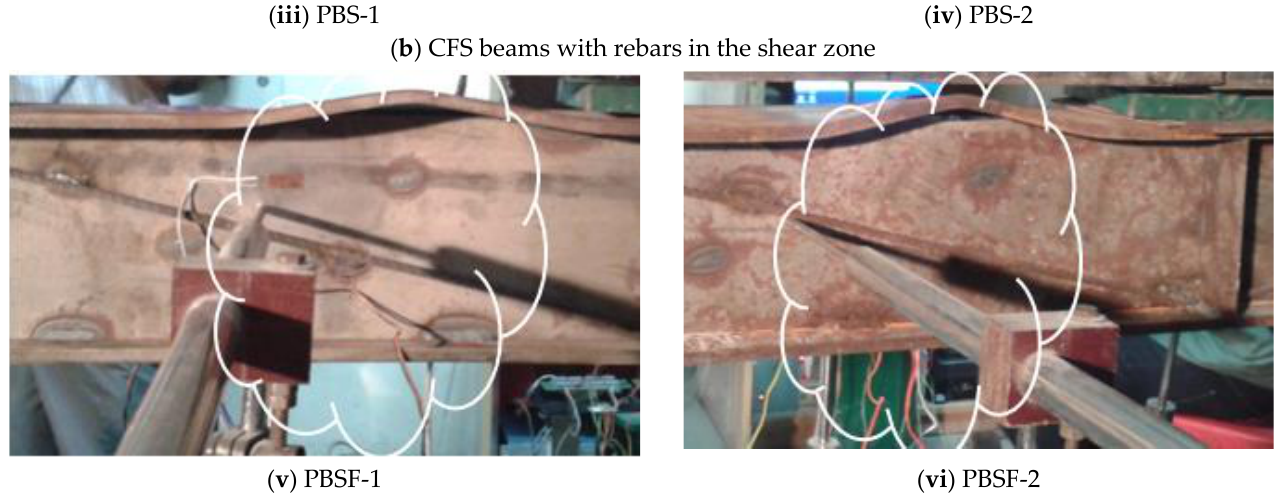
Figure 4. Photograph of the CFS beams at failure.